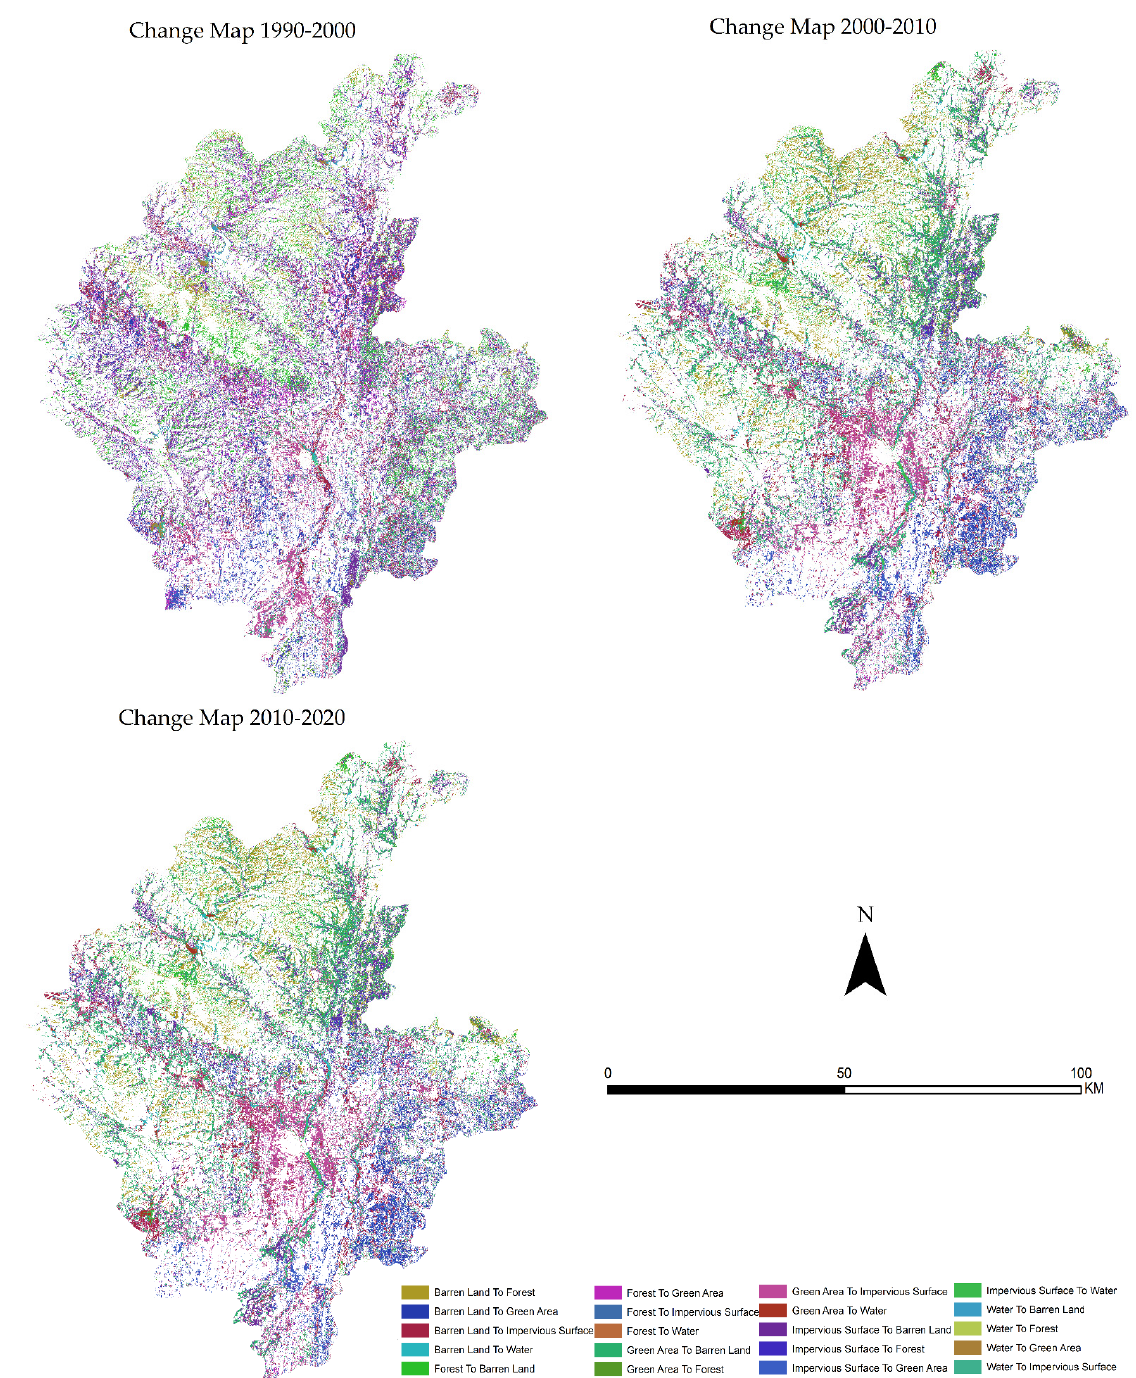
Figure 5. Linyi change maps 1990–2020.